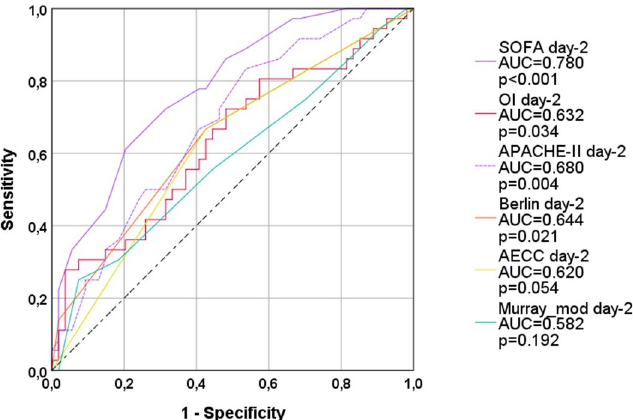
Fig 2. ROC-AUC regarding 28d-mortality (all patients; day 2). OI: oxygenation index; AECC: American European Consensus Conference; Murray_mod: modified Murray-score (sum of points without radiological points); AUC: area under the curve. APACHE-II: Acute Physiology And Chronic Health Evaluation; SOFA: Sequential Organ Failure Assessment.